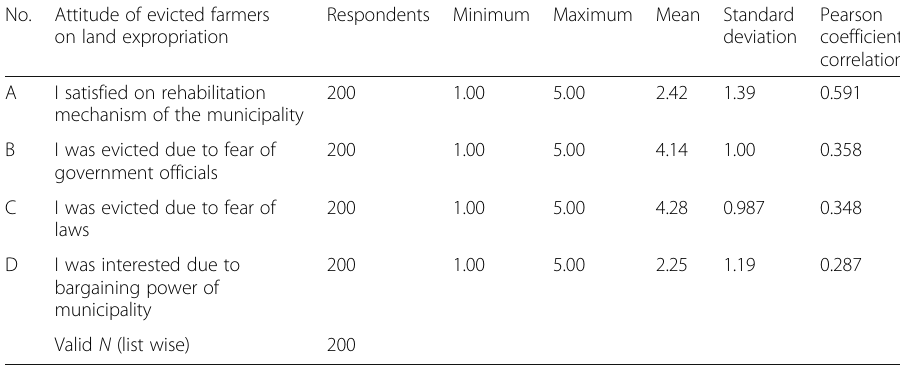
Table 8 Attitude of evicted farmers on land expropriation No. Attitude of evicted farmers on land